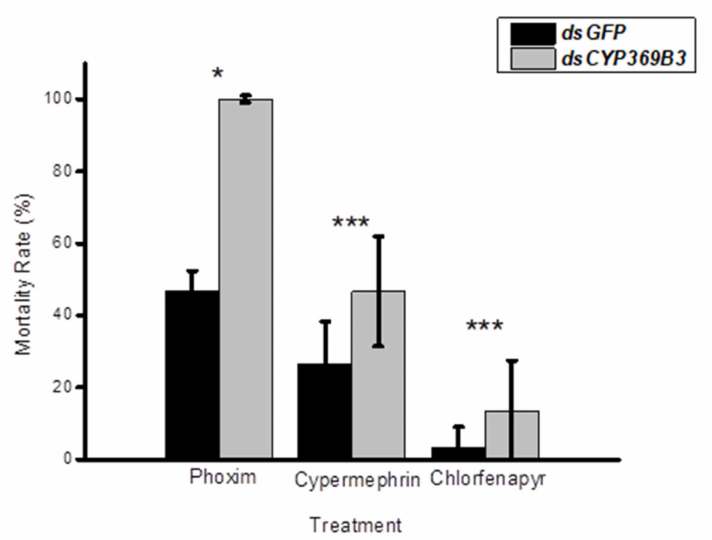
Figure 5. Effects of knocking down CYP369B3 on the mortality of Meteorus pulchricornis adults after treatment with insecticides. (* p < 0.05; *** p < 0.001). Square root transformation was applied to satisfy the hypothesis of